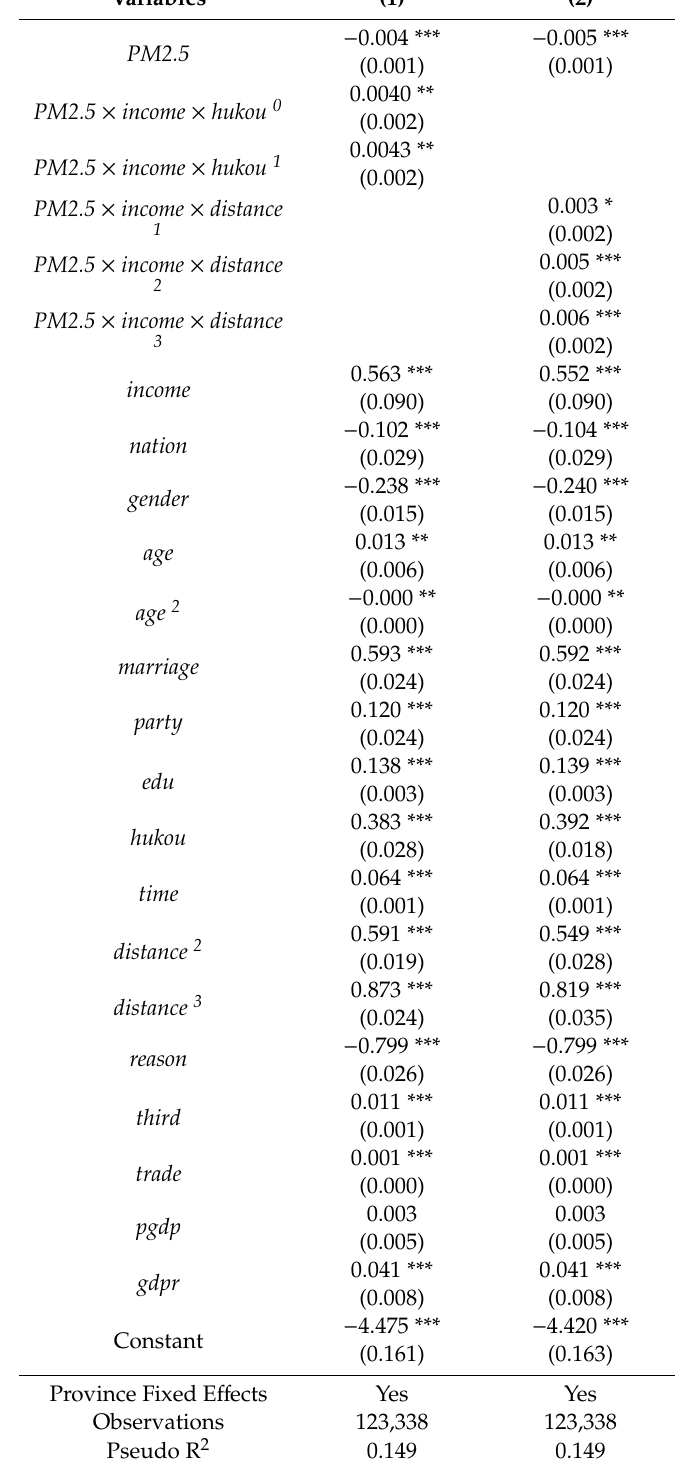
Table 5. Heterogeneity test for factors influencing the settlement intentions of Chinese migrants in cities with interaction terms